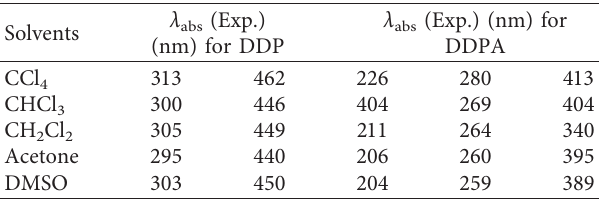
Figure 3: Experimental normalized absorption spectra (1 × 10 − 5 M) for DDP (a) and DDPA (b) in different solvents. Table 3: Experimental maximum absorption wavelengths λ abs (Exp.) in different solvents for DDP and DDPA molecular structures.